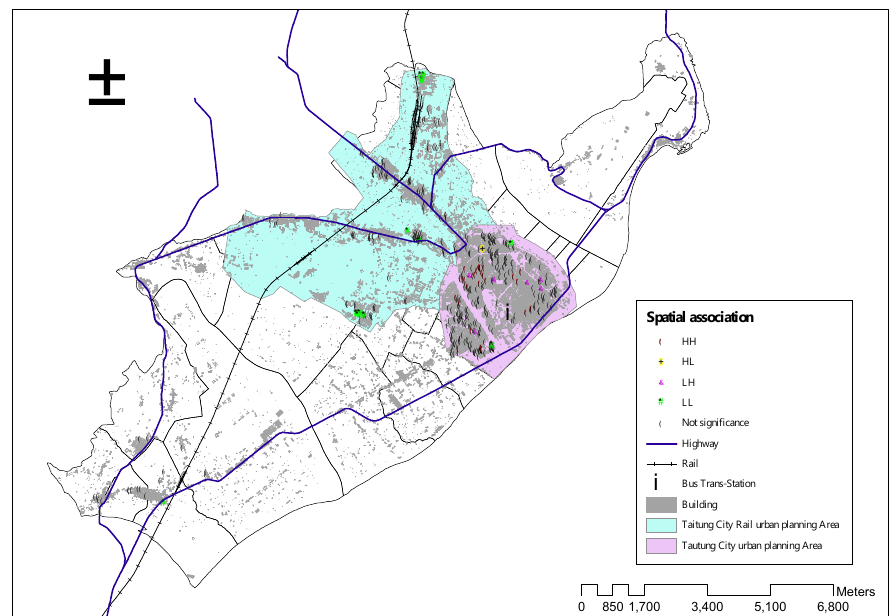
Figure 7. Spatial correlation map of real estate unit price in 2017.